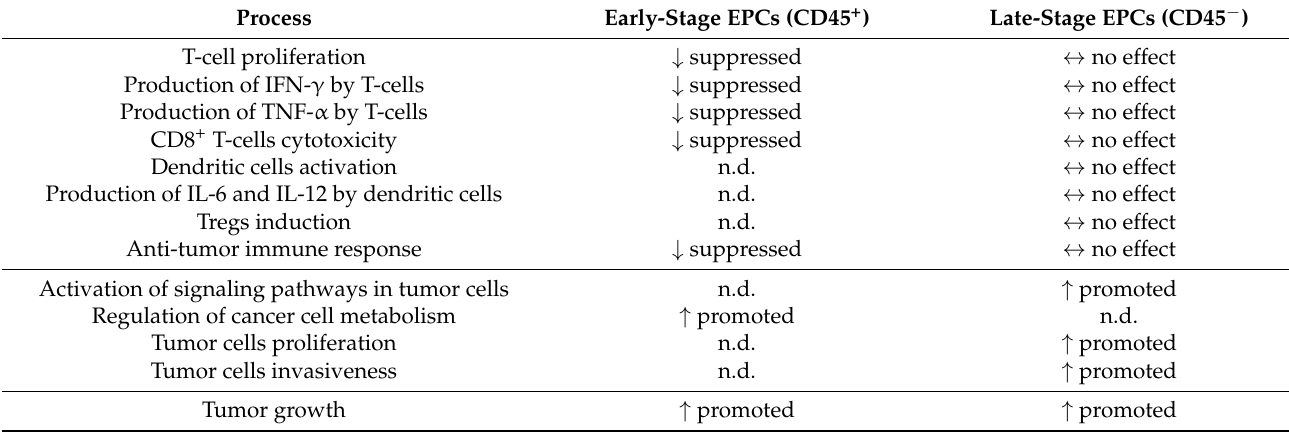
Table 5. Different role of early-stage and late-stage EPCs in cancer [41–43,62,116,123].